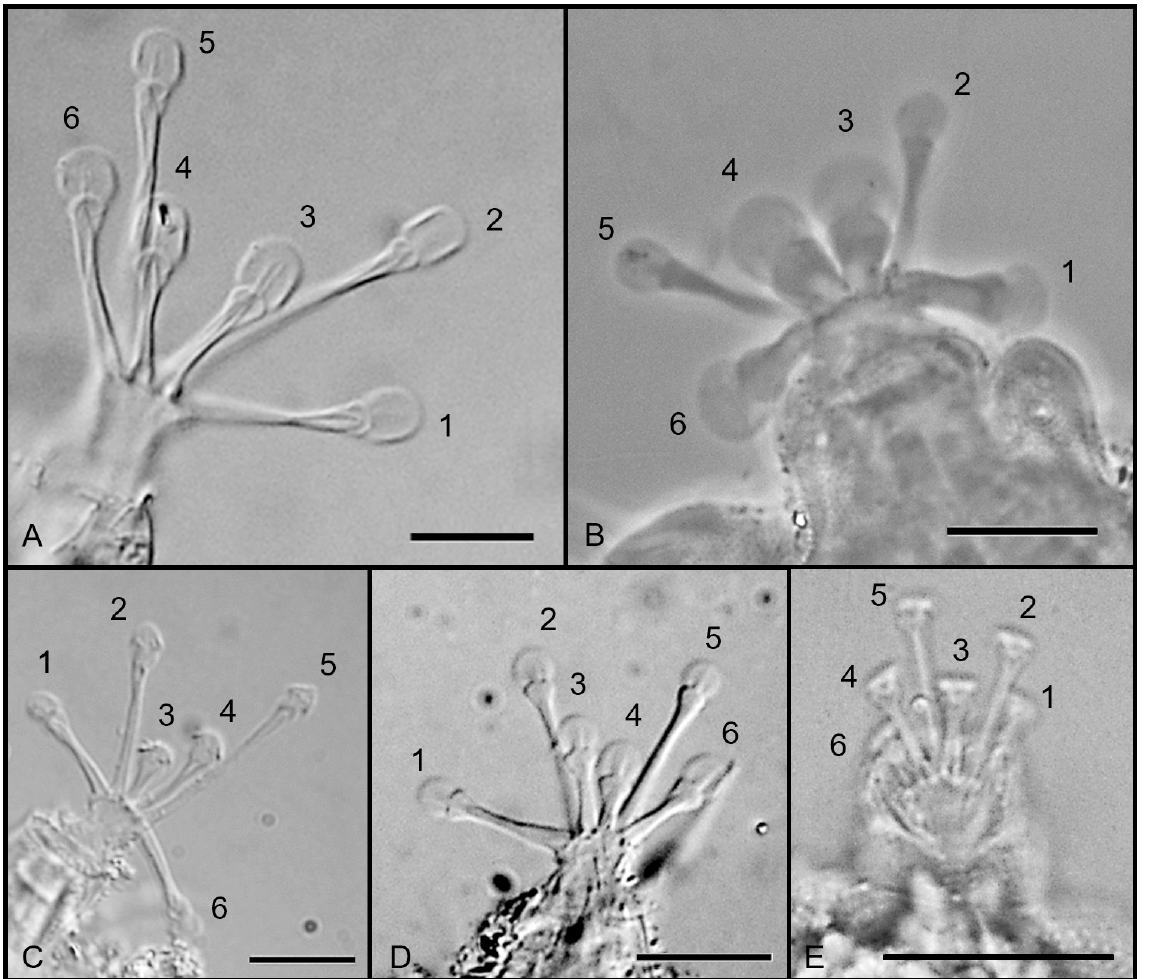
Fig. 9. Patterns of toe arrangement on the fourth feet of species of Batillipes Richters, 1909 (see text for details; toe 1 is the most cephalically). A . group A ( B. lusitanus sp. nov.). B . group A with very short middle toes ( B. pennaki Marcus, 1946). C . group B , subgroup B1 ( B. brasiliensis Santos, da Rocha, gomes Jr. & Fontoura, 2017). D . group B , subgroup B2 ( B. algharbensis sp. nov.). E . group C ( B. acuticauda Menechella, Bulnes & Cazzaniga, 2015). Scale bars = 10